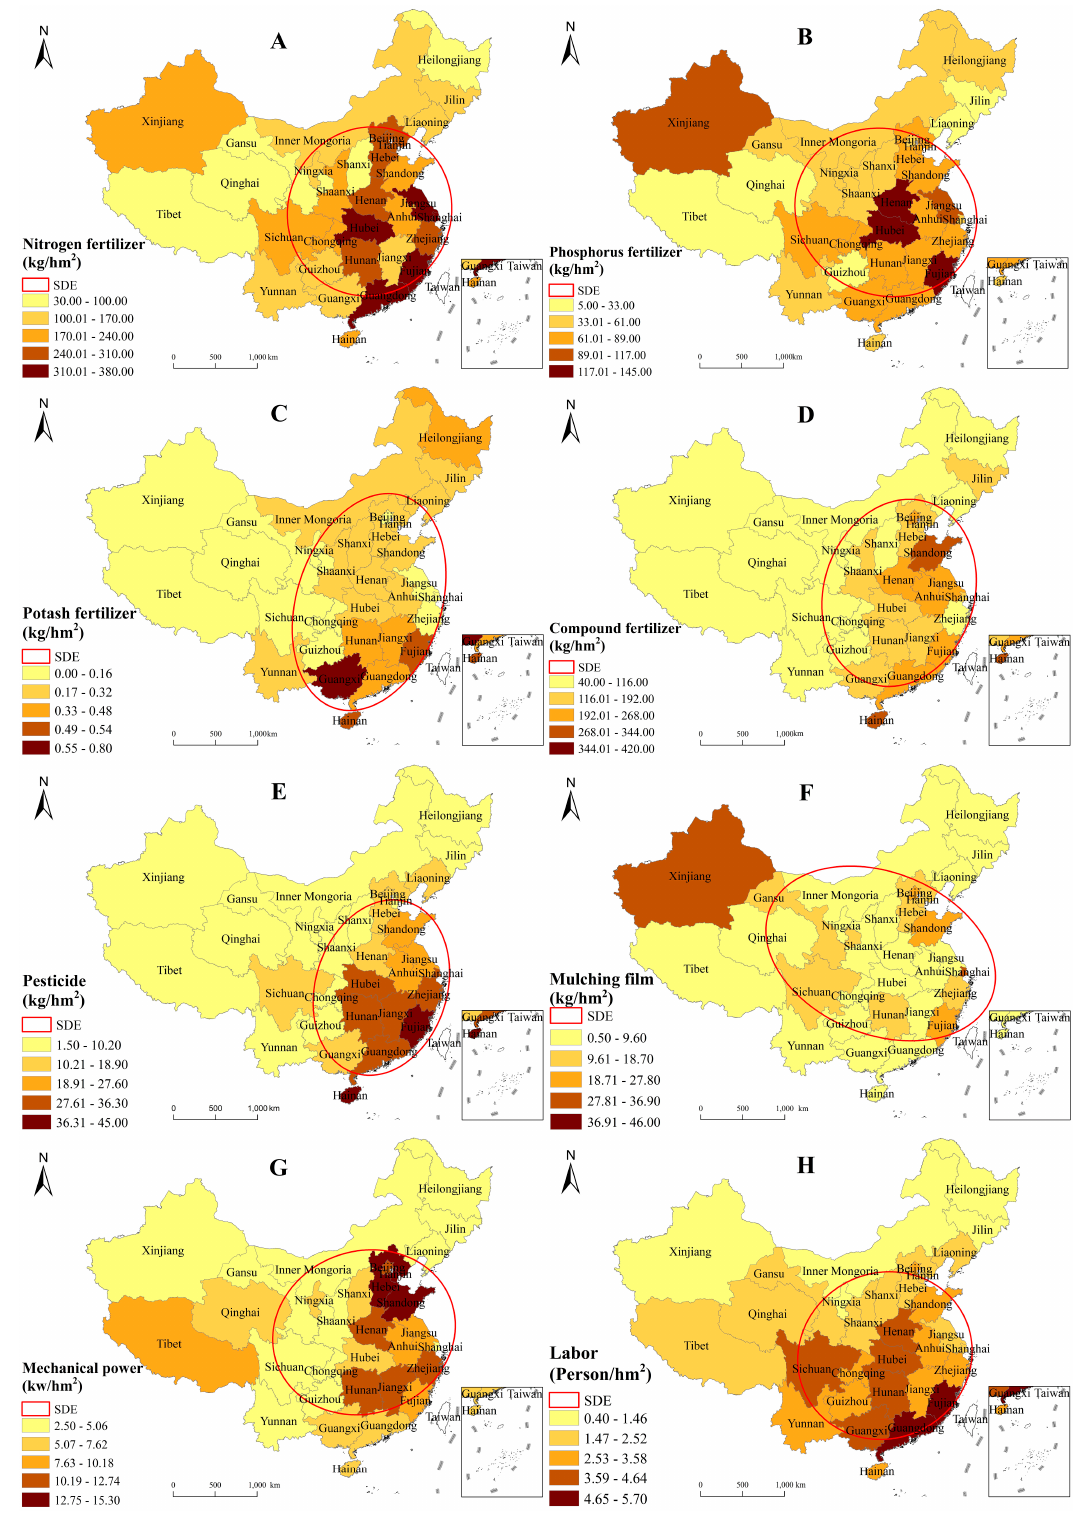
Figure 4. Input of production material on per unit area of arable land in 2008.